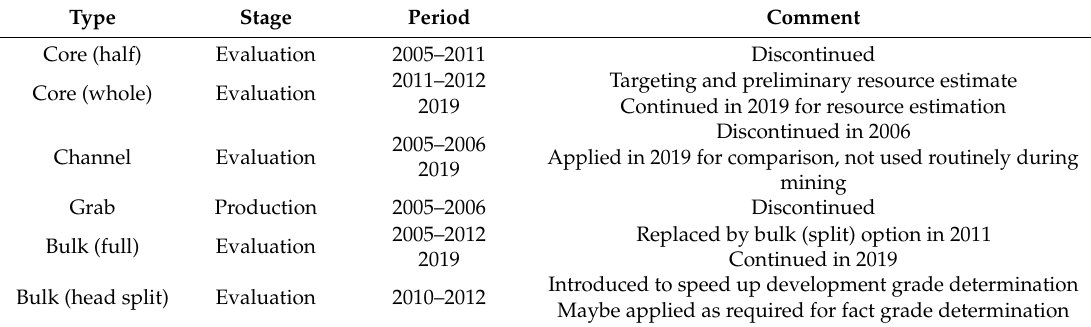
Table 26. Summary of sample types used at San